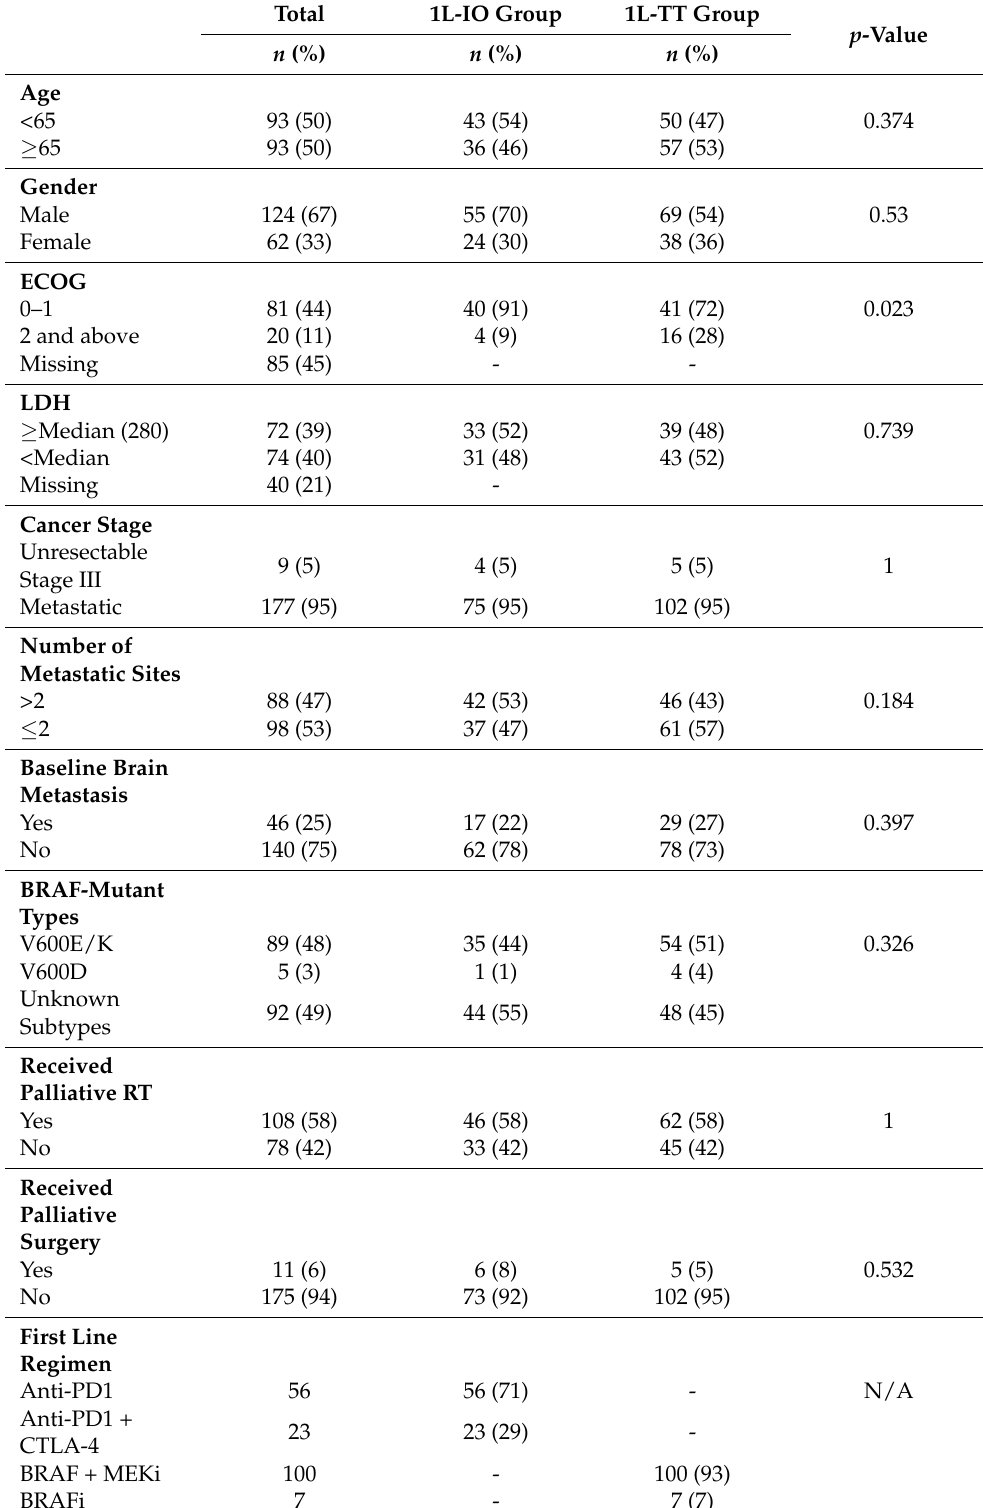
Table 1. Baseline study population characteristics ( n =